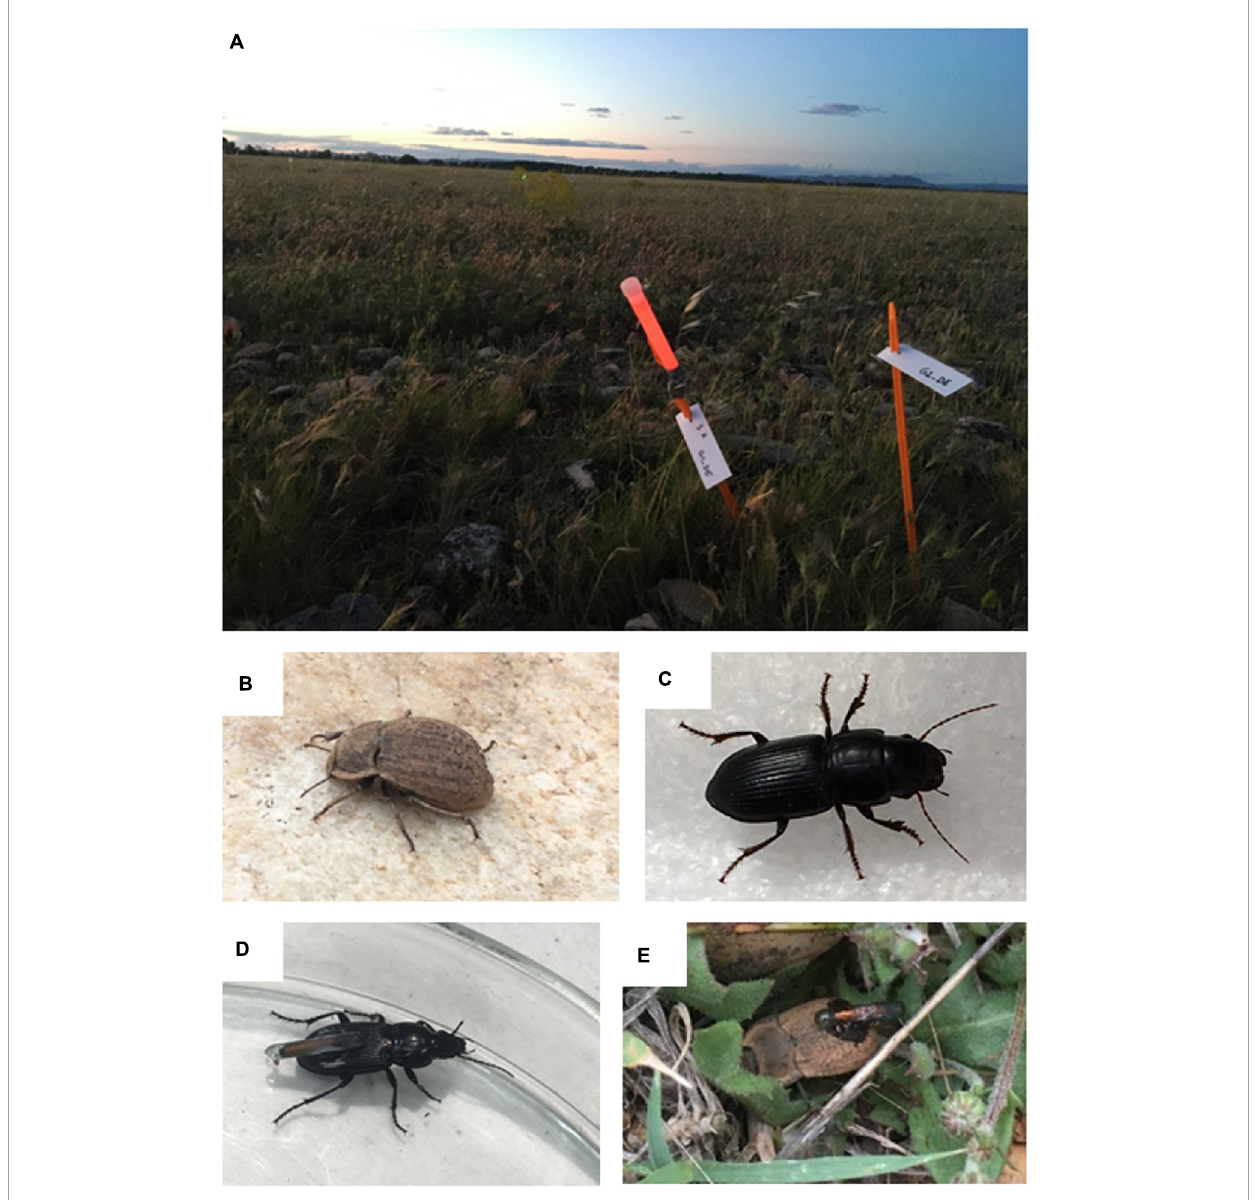
FIGURE1 Study species and study area (A) the dry grasslands of la Crau and marking of release points, (B) Asida sericea , (C) Acinopus picipes , (D) Poecilus sericeus equipped with an RFID-tag on its back, (E) Asida sericea equipped with an RFID-tag and released in the field.